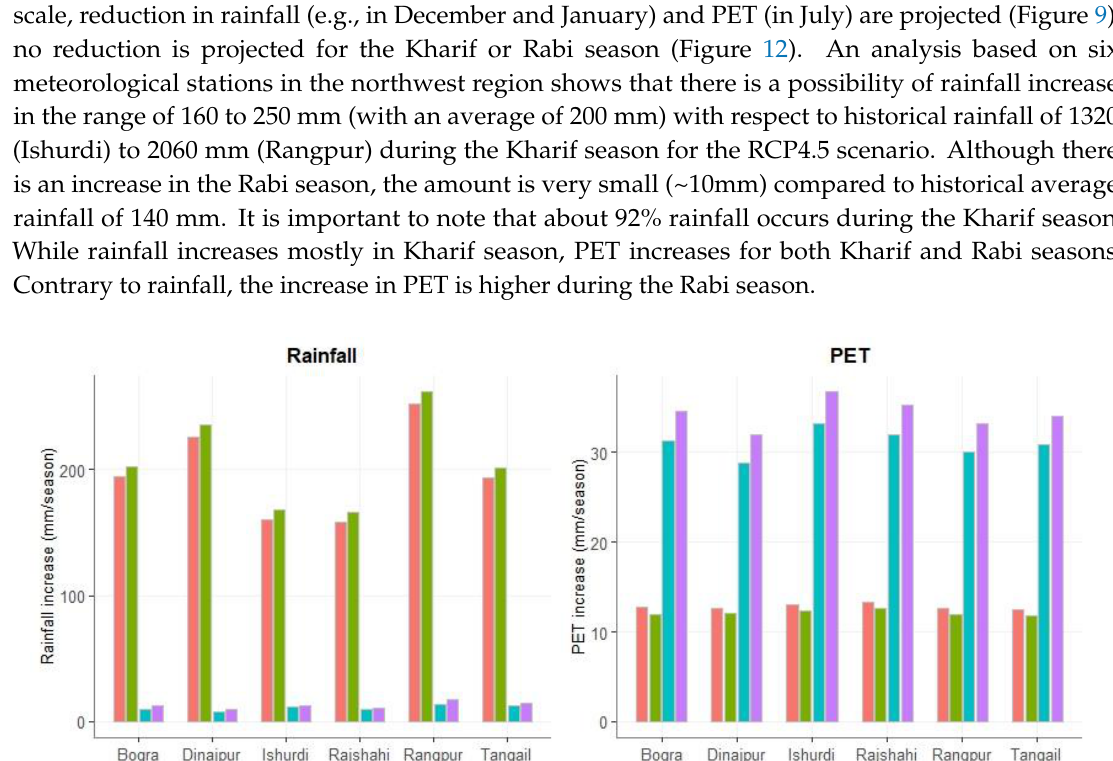
Figure 11. Projected changes in rainfall (upper panel) and PET (lower panel) at six meteorological stations in the northwest region of Bangladesh for the five scenarios (S1 to S5).